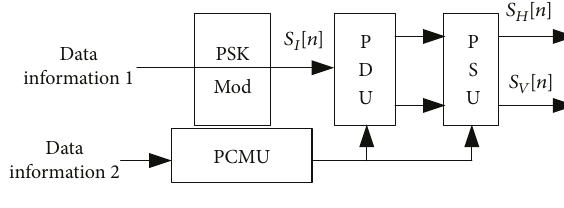
Figure 5: Joint modulation unit.